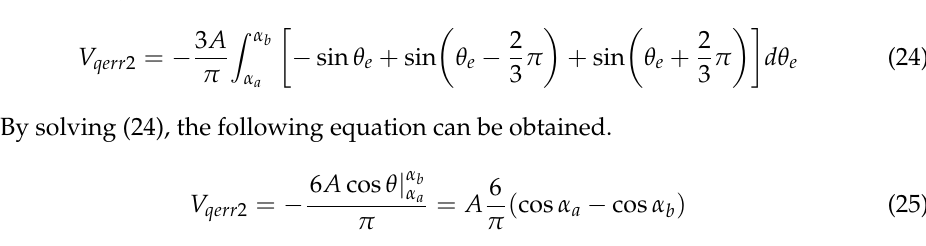
Figure 6 shows the waveform of nonlinear voltage on 0-axis. The equivalent value of the 0-axis nonlinear voltage is related to α c , as shown in (26).